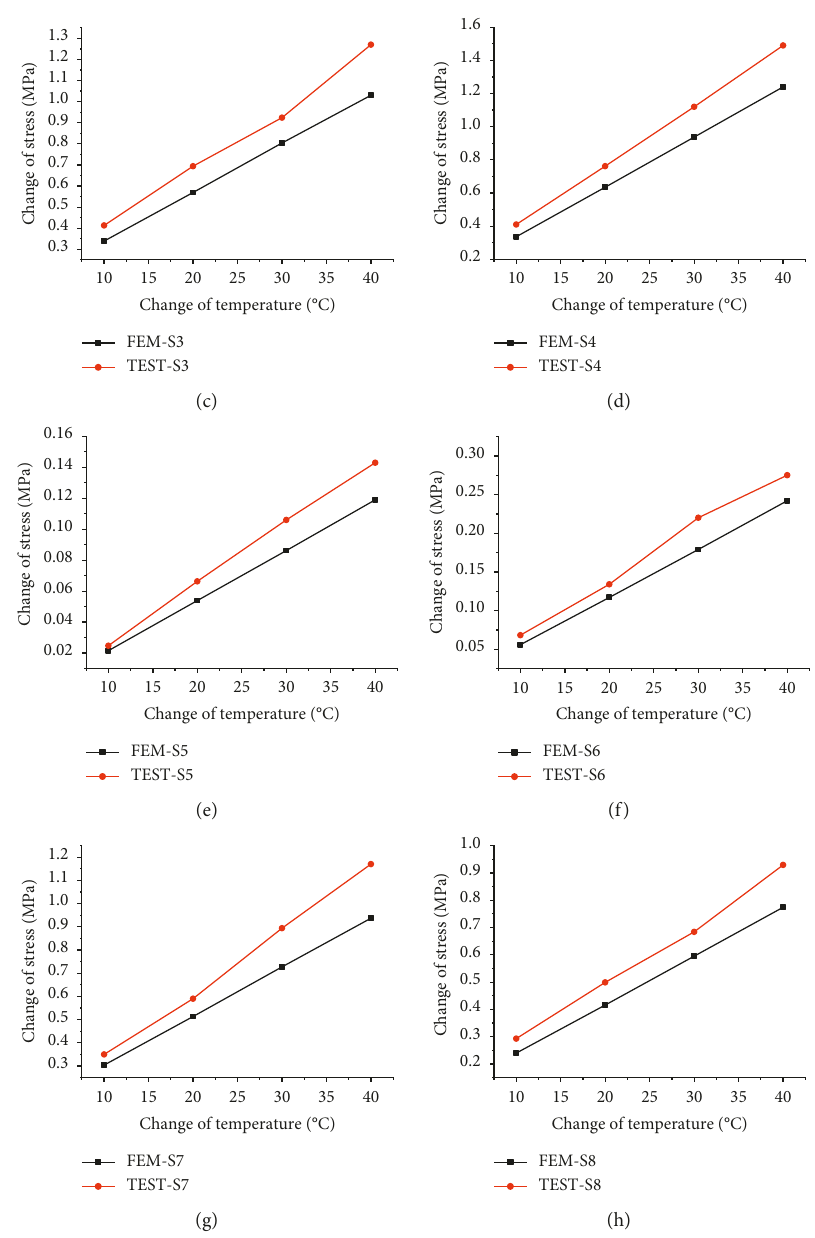
Figure 20: Comparison of the change in the USSM stress in the experiments and finite element numerical simulations under the half-span load. Change in the force of (a) S1, (b) S2, (c) S3, (d) S4, (e) S5, (f) S6, (g) S7, and (h) S8 under the half-span